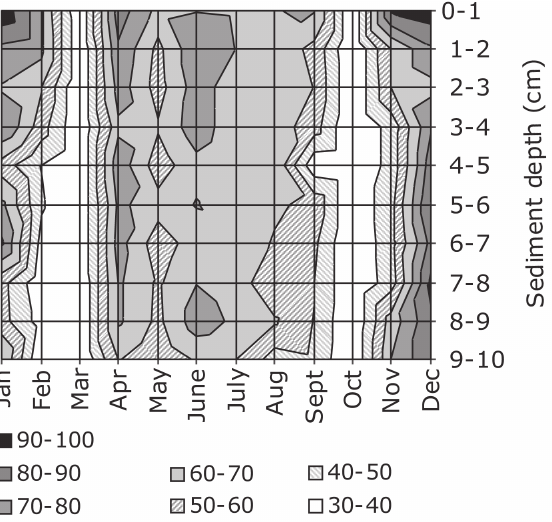
Fig . 2. – organic matter (mg g -1 ) of sediment samples from depths of 0-10 cm.